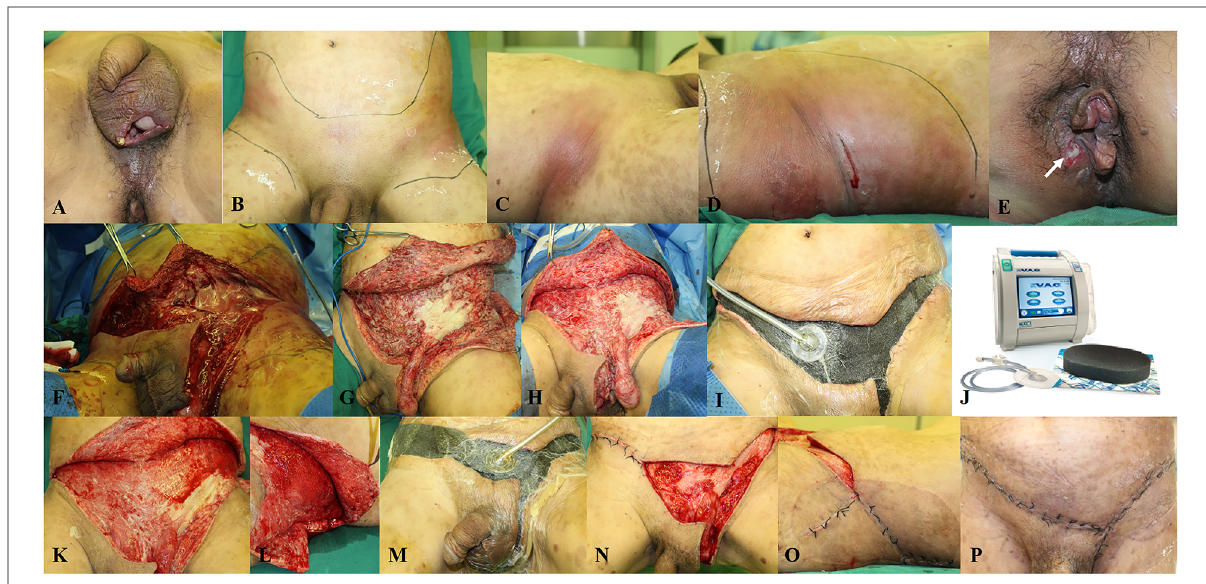
FIGURE 1 A representative case of a 50-year-old patient diagnosed with fournier gangrene and transferred to our department. ( A – D ) Despite incision and drainage of the scrotum before admission, the infection spread to the lower and lateral abdominal wall. ( E ) The etiology is the perianal abscess (white arrow). ( F ) Emergency surgical debridement is performed. ( G ) Appearance after debridement. ( H ) Appearance before the second debridement. ( I ) NPWT is applied during the third debridement. ( J ) The V.A.C. system used in our department. ( K,L ) Appearance before the fourth debridement. ( M ) Part of the wound is closed and NPWT is continued after the fourth debridement. ( N,O ) Appearance before the fi fth debridement; the rest of the wound is closed. ( P ) Appearance before